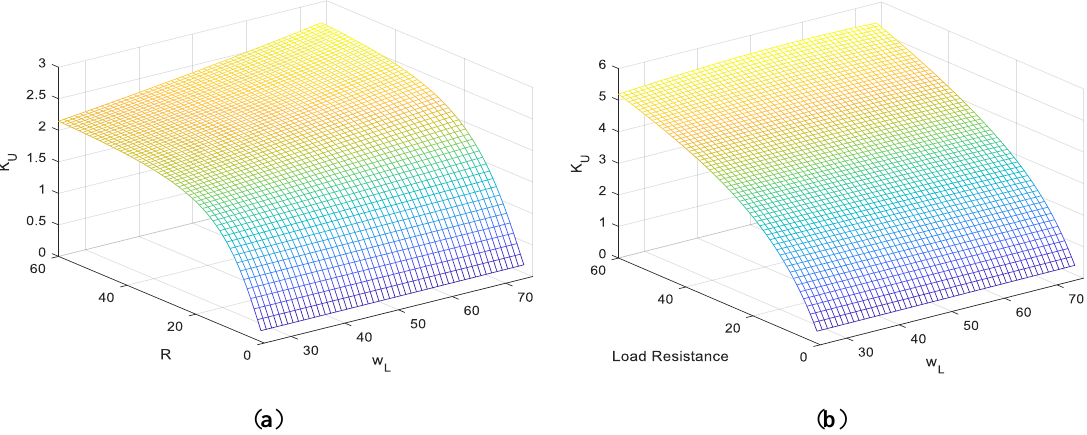
Figure 14. Impact of the load and setting output voltage frequency on the voltage gain: ( a ) Venturini modulation q = 0.5, ( b ) SVM for q = 0.866 and ϕ i = 0.